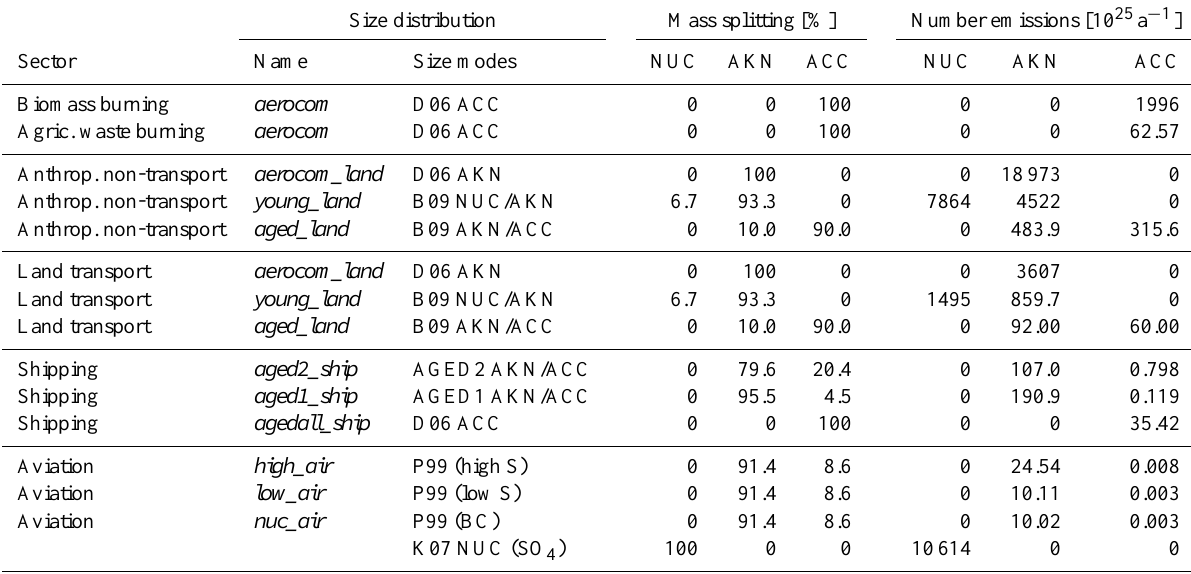
Table B1. Assumed size distributions and resulting mass splitting and total particle number emissions for the reference and sensitivity experiments. The nucleation, Aitken and accumulation modes are indicated by NUC, AKN and ACC, respectively. The nucleation and Aitken modes are both assigned to the Aitken mode of MADE. The size distribution parameters for each size mode are given in Table